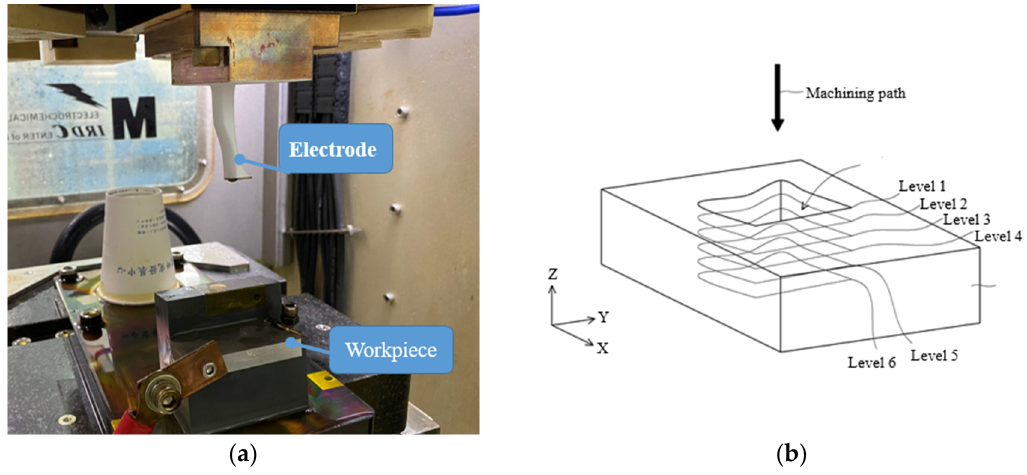
Figure 2. ( a ) ECM processing; ( b ) Machine schematic. Table 1. ECM